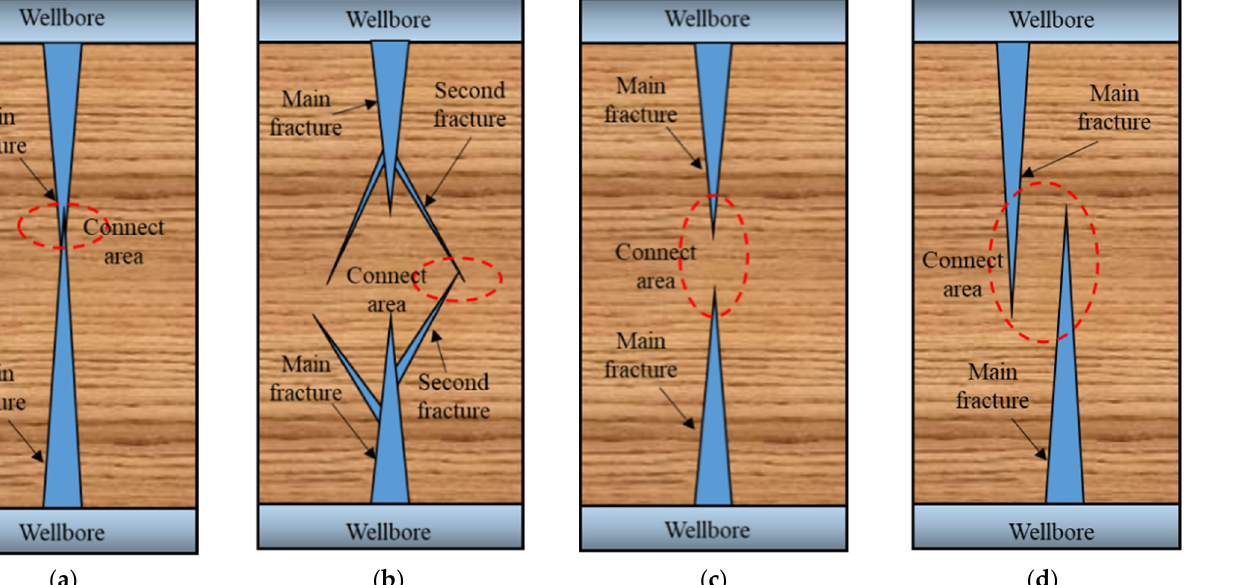
Figure 12. Four types of fractures connectivity by interwell interference. ( a ) shows the direct connection due to the excessive extension of the fractures. ( b ) shows the connection of two branch fractures. ( c ) shows the connection of two opposing fractures through the matrix. ( d ) shows two parallel fractures con-nected through the matrix.